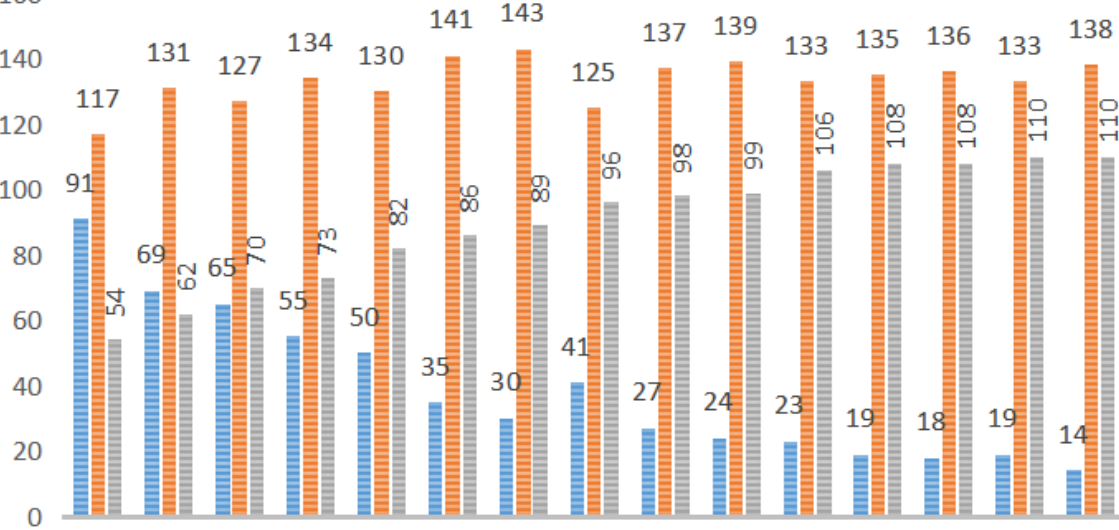
Figure 4. The number of cities in different levels of human capital zones from 2004 to 2018.